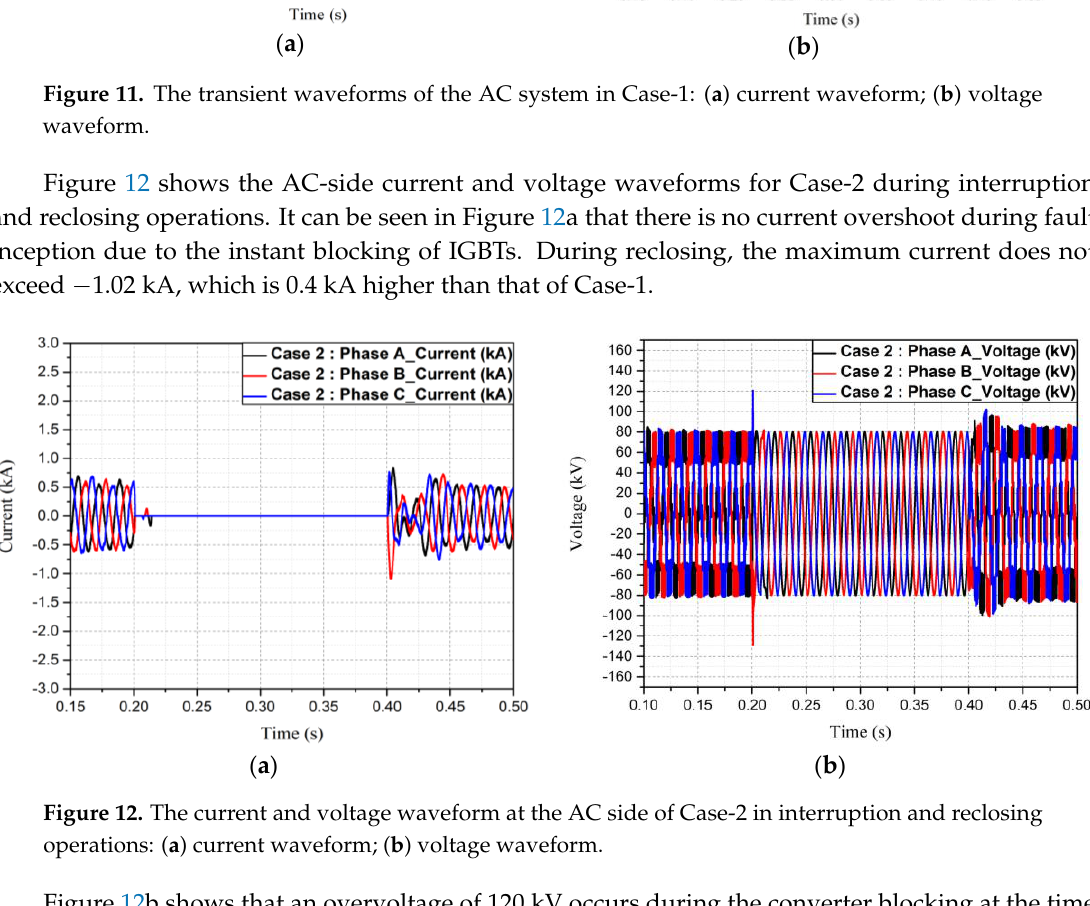
Figure 11. The transient waveforms of the AC system in Case-1: ( a ) current waveform; ( b ) voltage waveform.